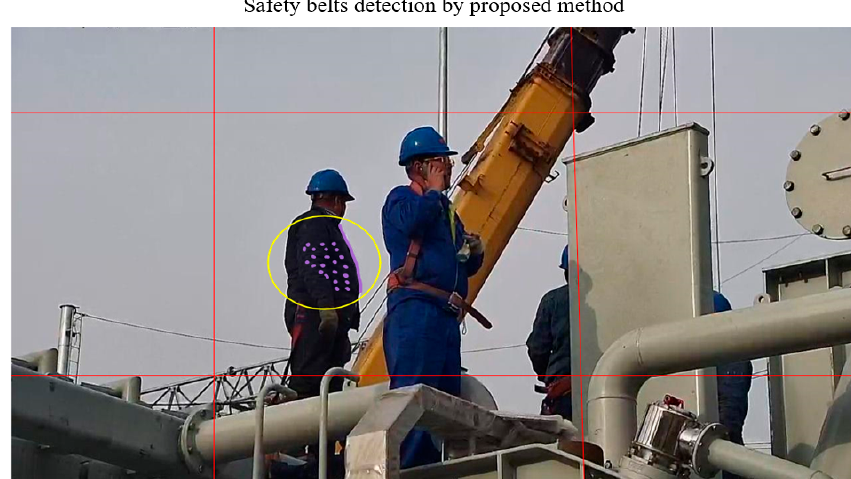
Figure 14. Workwear detection.